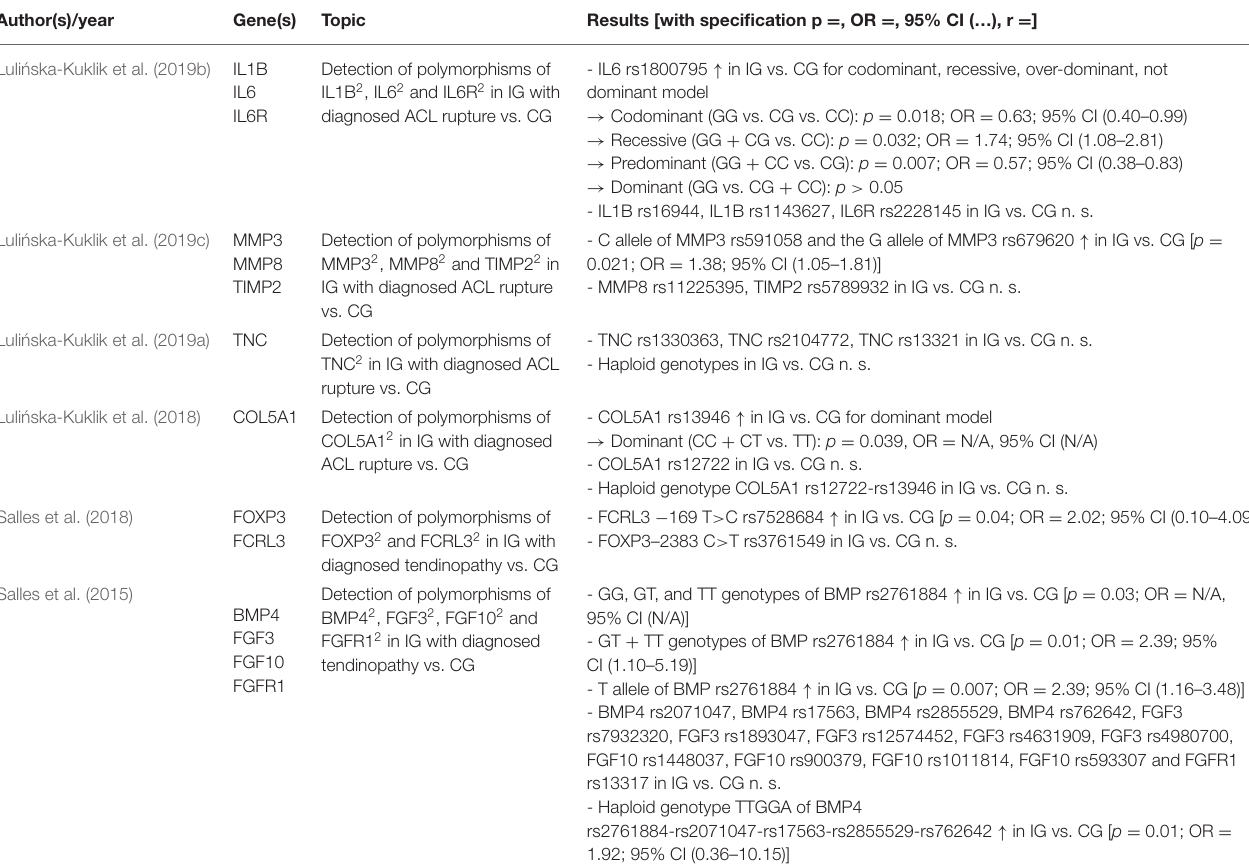
TABLE 7 | Results of included studies investigating an association between genetic variants and vulnerability to injury. Author(s)/year Gene(s) Topic Results [with specification p = , OR = , 95% CI (…), r = ] Detection of polymorphisms of IL1B 2 , IL6 2 and IL6R 2 in IG with IL6R diagnosed ACL rupture vs.